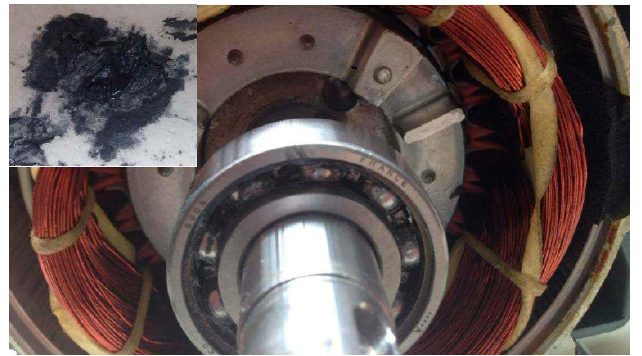
Figure 4. Bearing contamination with silicon carbide (SiC).